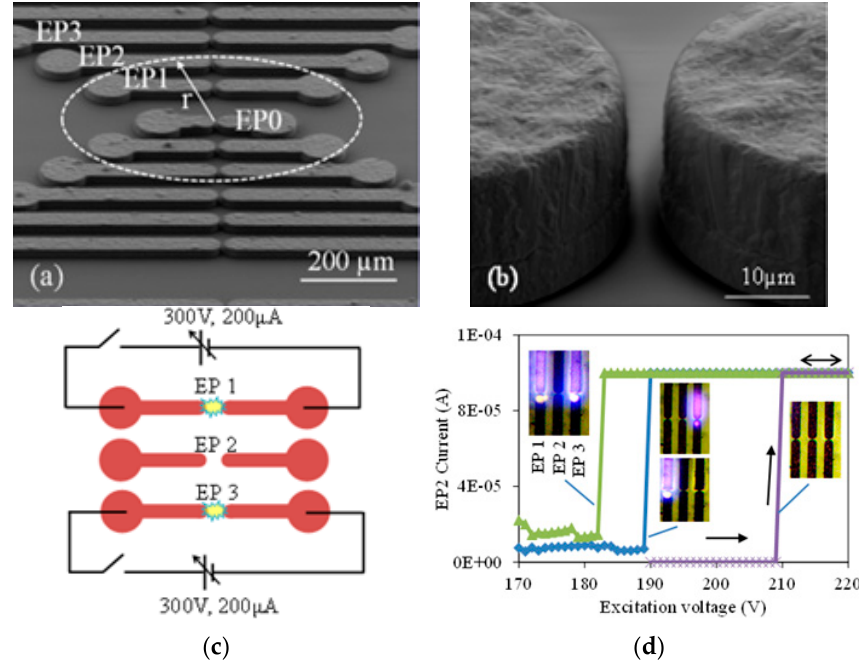
Figure 14. SEM micrograph of devices used for logic gates: ( a ) the adjacent devices are separated by 100 μ m; and ( b ) a close-up of one of the electrode pairs. The electrode configuration used to determine the effect of space charge on breakdown voltage of nearby device ( c ); and the experimental results ( d ). Inset shows optical images of the device during operation. All figures are reproduced from [35].